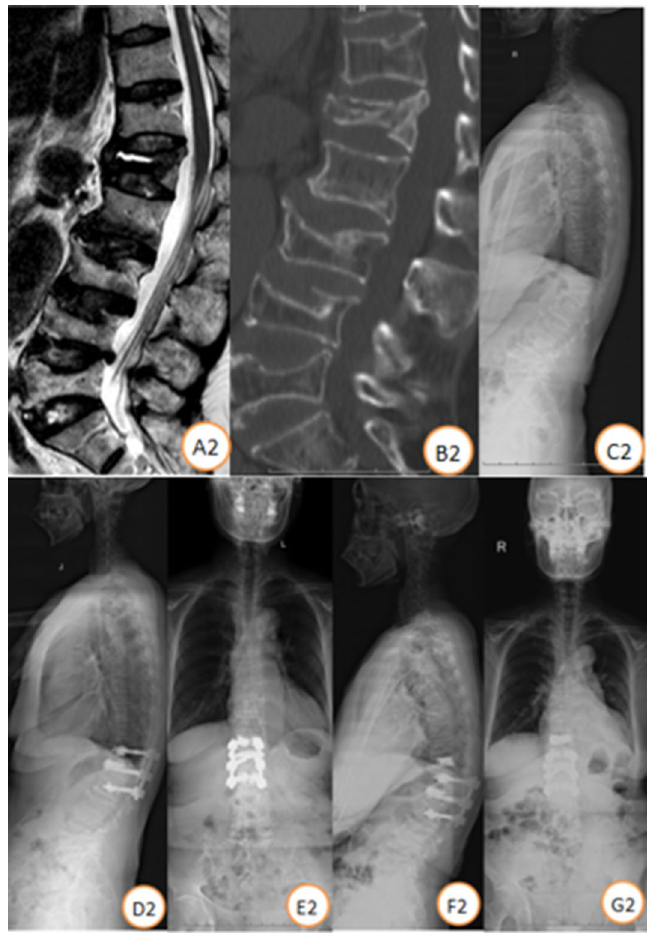
Figure 3. Case illustration of a patient. Female, 62 years, BMD (T score) was − 3.8SD. ( A2–C2 ) Preoperative lateral X-ray and CT scan showed L1 vertebral fracture with, MRI showed low signal of the necrotic area on T2-weighted images. Follow-up standing X-ray at 3 months ( D2,E2 ) and 4 year ( F2,G2 ) post T12-L2 bone cement-augmented pedicle screw